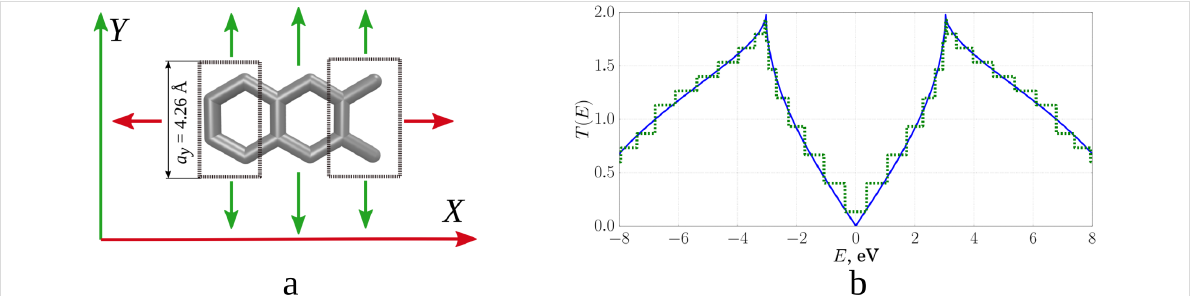
Figure 1: Graphene: a) unit cell with electrodes; b) transmission function (green: d k = 0.1 1/Å, blue: d k = 0.0015 1/Å).